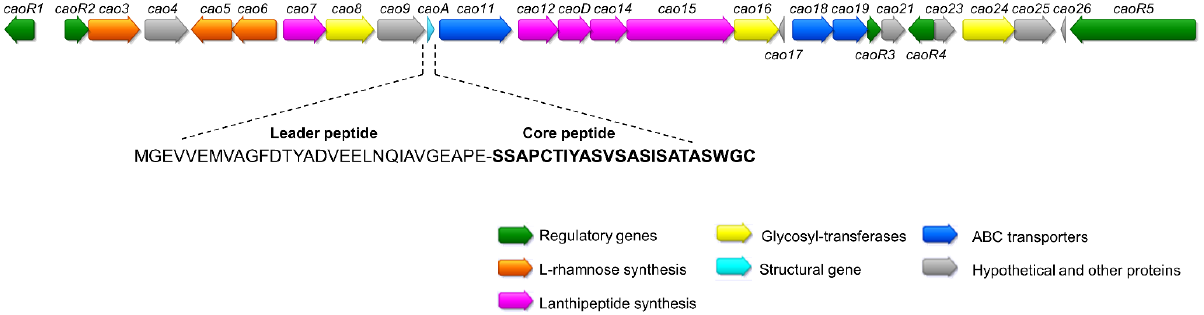
Figure 2. Schematic representation of the BGC of cacaoidin, where caoA codes for the precursor peptide. The sequences of the leader and core peptides of cacaoidin are shown. Table 1. Closest BLAST homolog for each Open Reading Frame (ORF) in cacaoidin Biosythetic Gene Cluster (BGC).